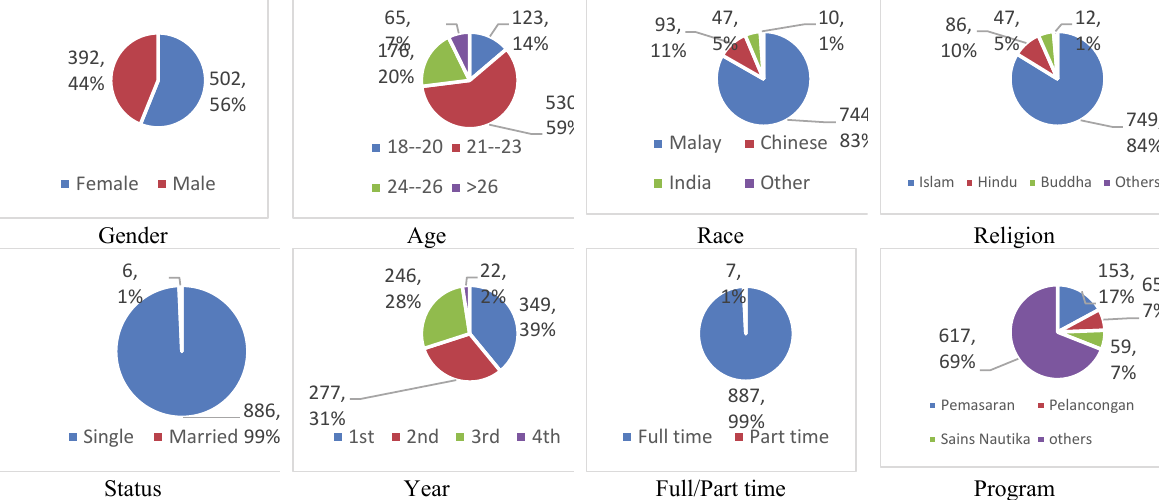
Fig. 2. Demographic data for